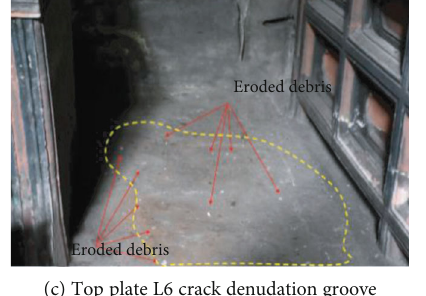
Figure 3: Water damage and surface erosion on the roof of the Yuanjue